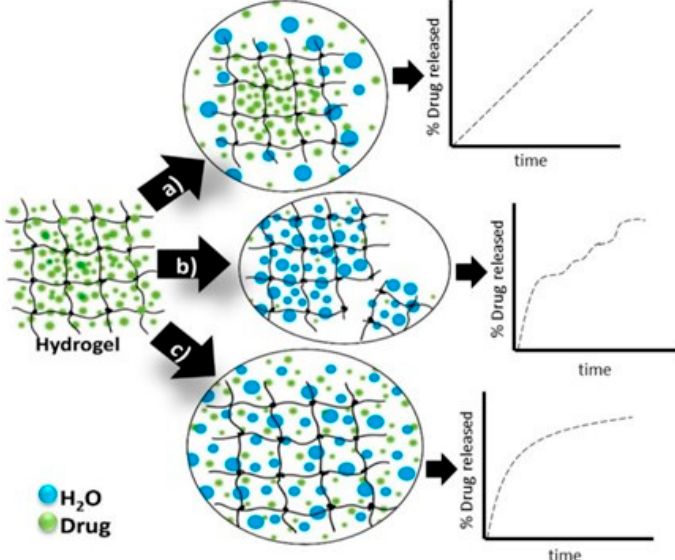
Figure 4. Hydrogels drug-release mechanisms and their respective kinetic profiles: ( a ) the case when the governing mechanism is given by the drug diffusion; ( b ) when it is imposed by the degradation of the polymeric matrix; ( c ) when the hydrogel swelling governs the process. [51].